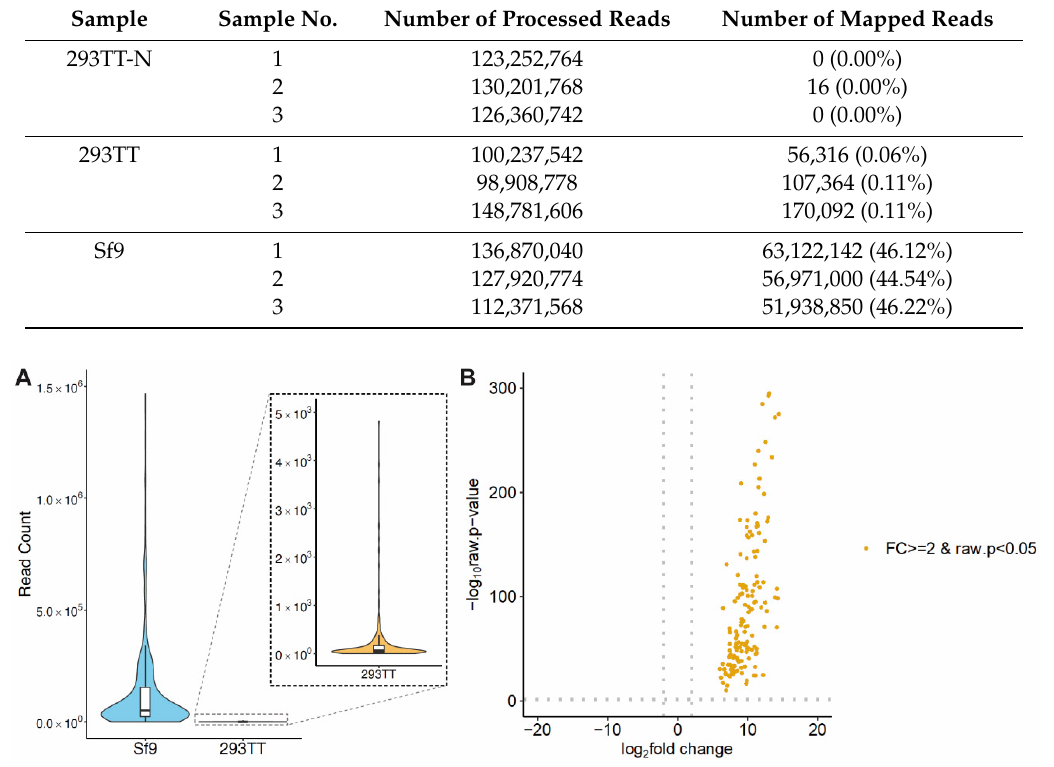
Figure 3. Comparative baculovirus transcriptome profiles of recombinant baculovirus-infected human and insect cells. ( A ) Violin plots illustrate read counts obtained for AcHERV env -CMV-GFP-infected 293TT and Sf9 cells. ( B ) Volcano plot shows the fold change (log 2 transformed) and variance for all transcripts in AcHERV env -CMV-GFP-infected 293TT cells relative to virus-infected Sf9 cells. Differentially expressed transcripts are highlighted in orange. Dotted gray lines indicate two-fold changes and a p -value ≤ 0.05.